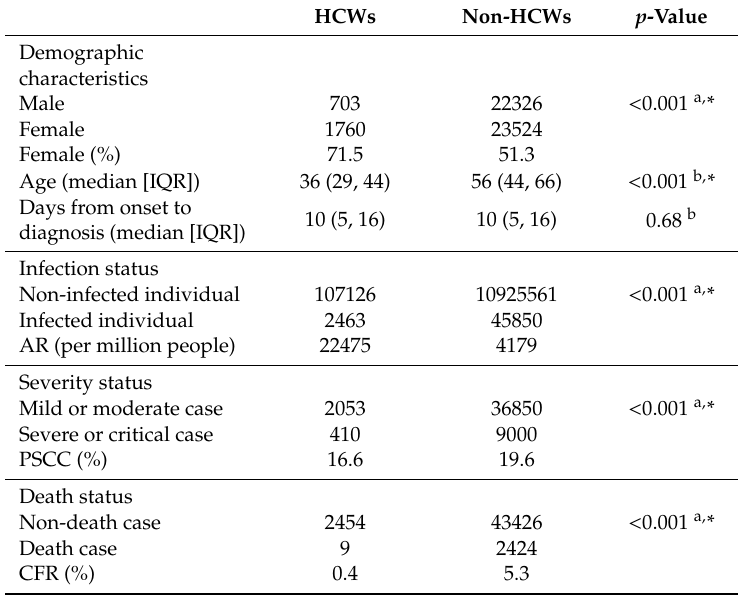
Table 1. Comparison of basic characteristics between healthcare workers (HCWs) and non-HCWs in